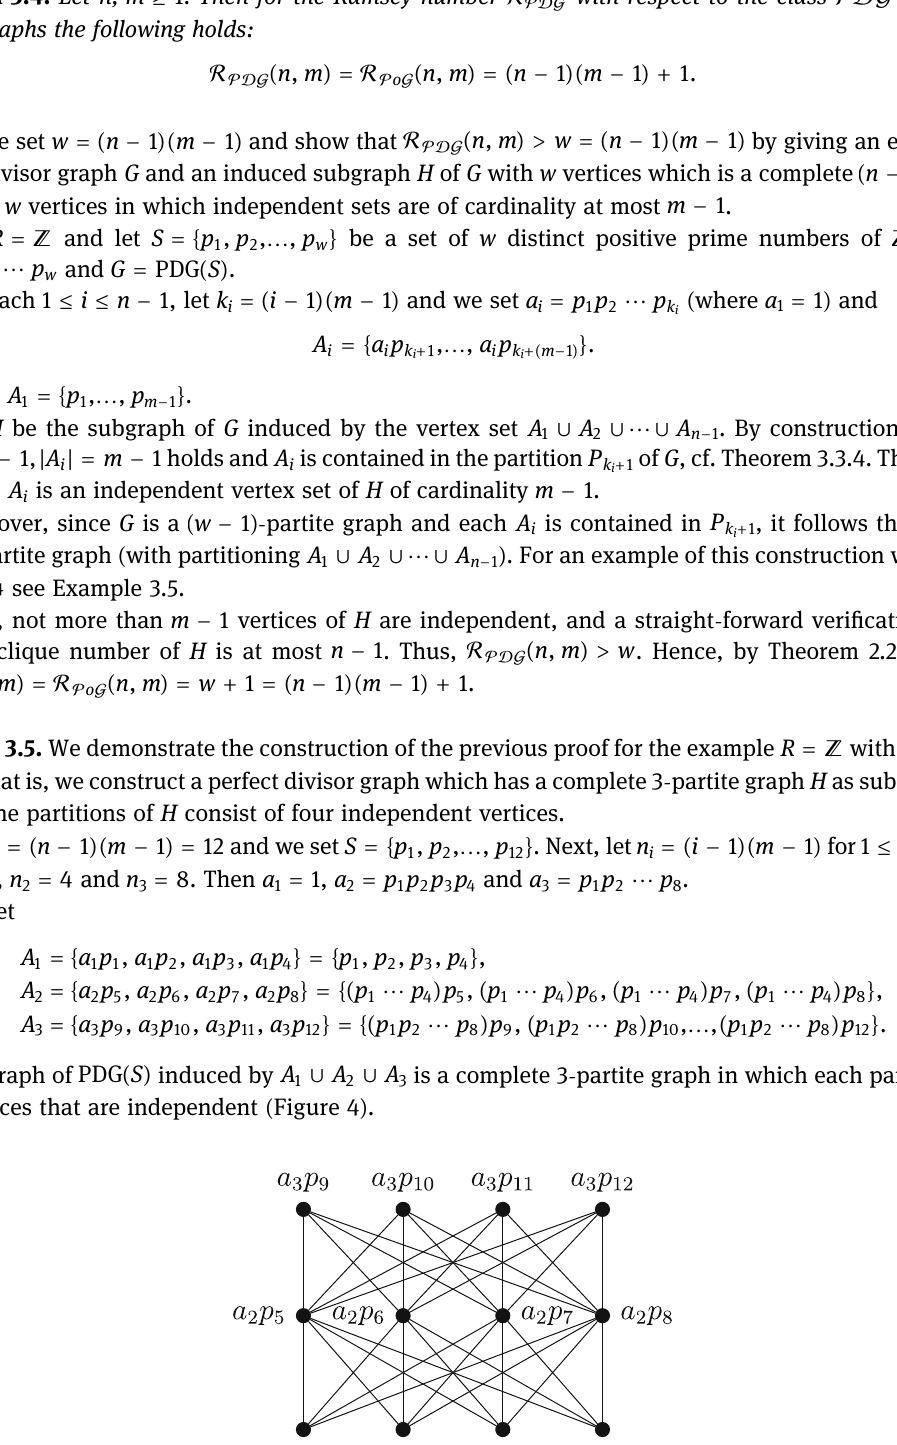
where, for better visibility, the edges between A 1 and A 3 are “ hidden ” behind Figure 4: Induced subgraph H of ({ }) p p PDG ,…, 1 12 the edges between A 1 and A 2 and the edges between A 2 and A 3